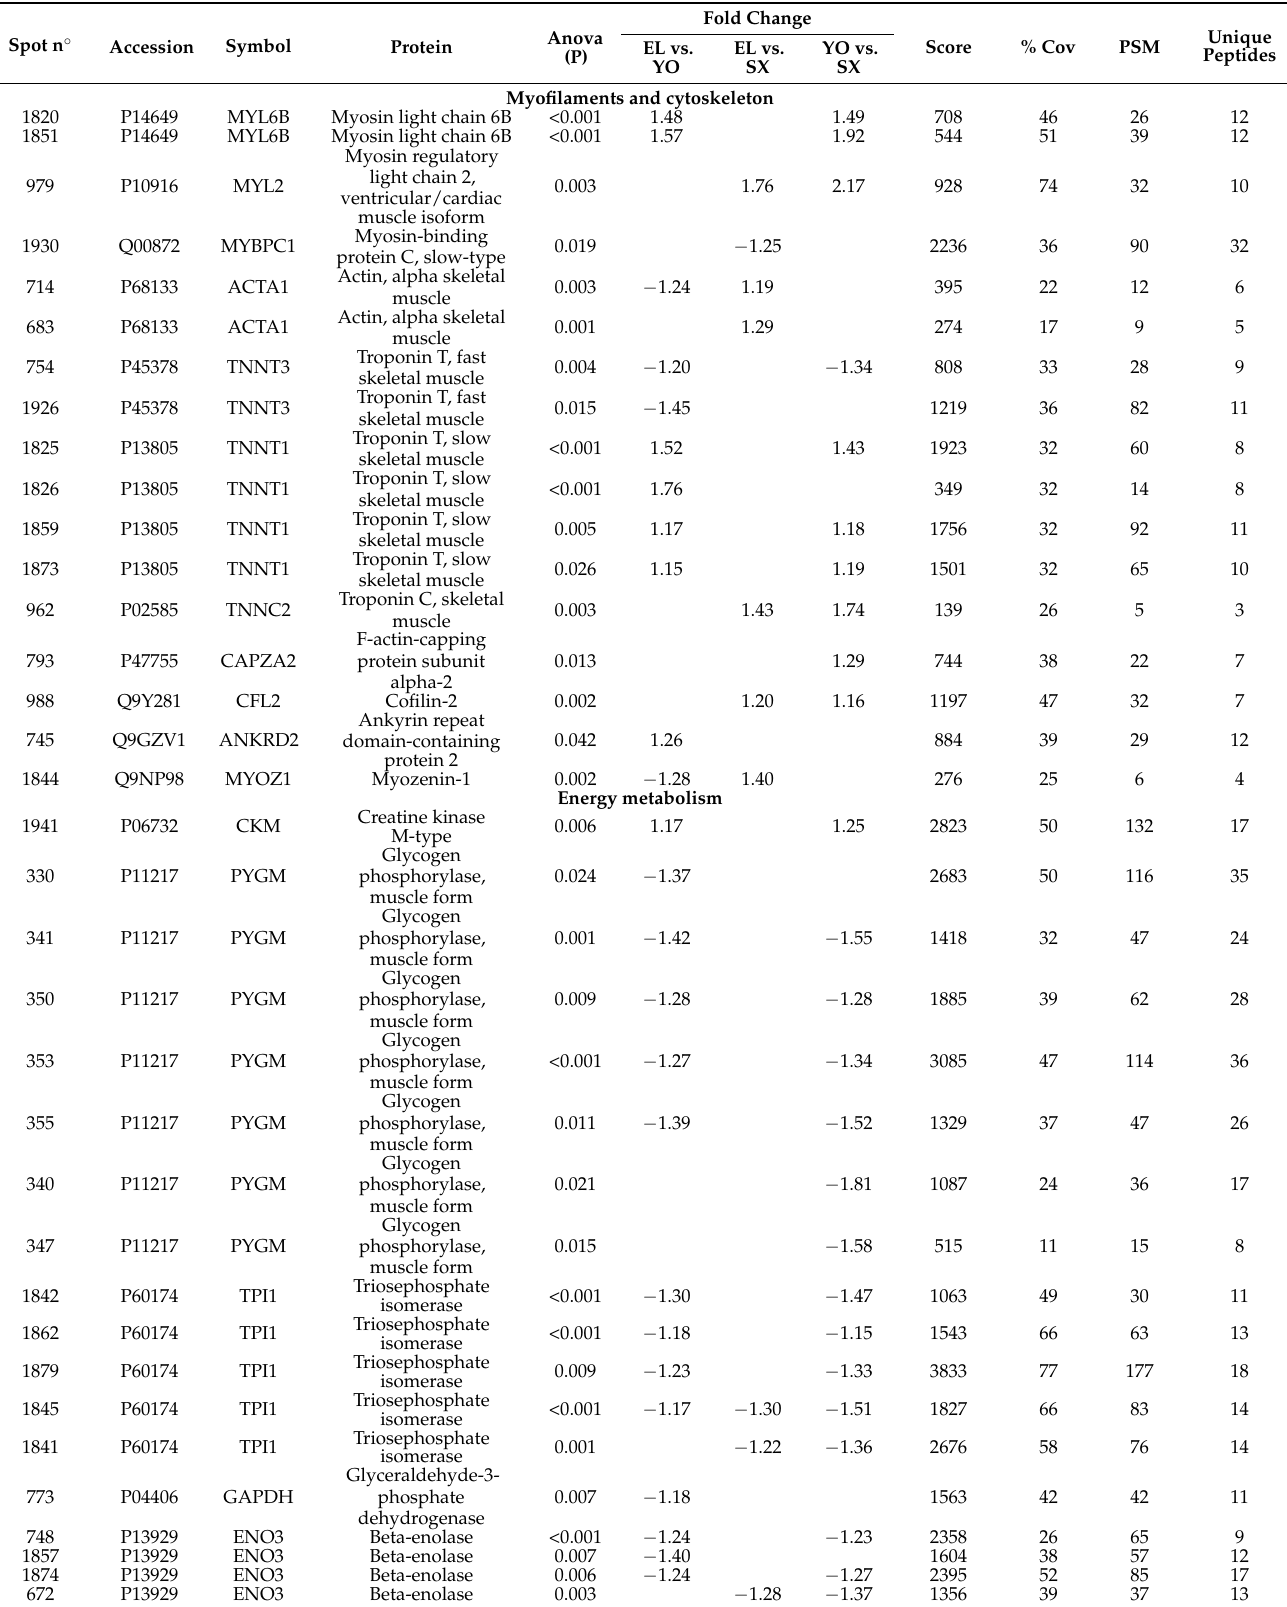
Table 2. Identification of differentially expressed protein in vastus lateralis muscle of young (YO), healthy elderly (EL) and elderly with metabolic syndrome